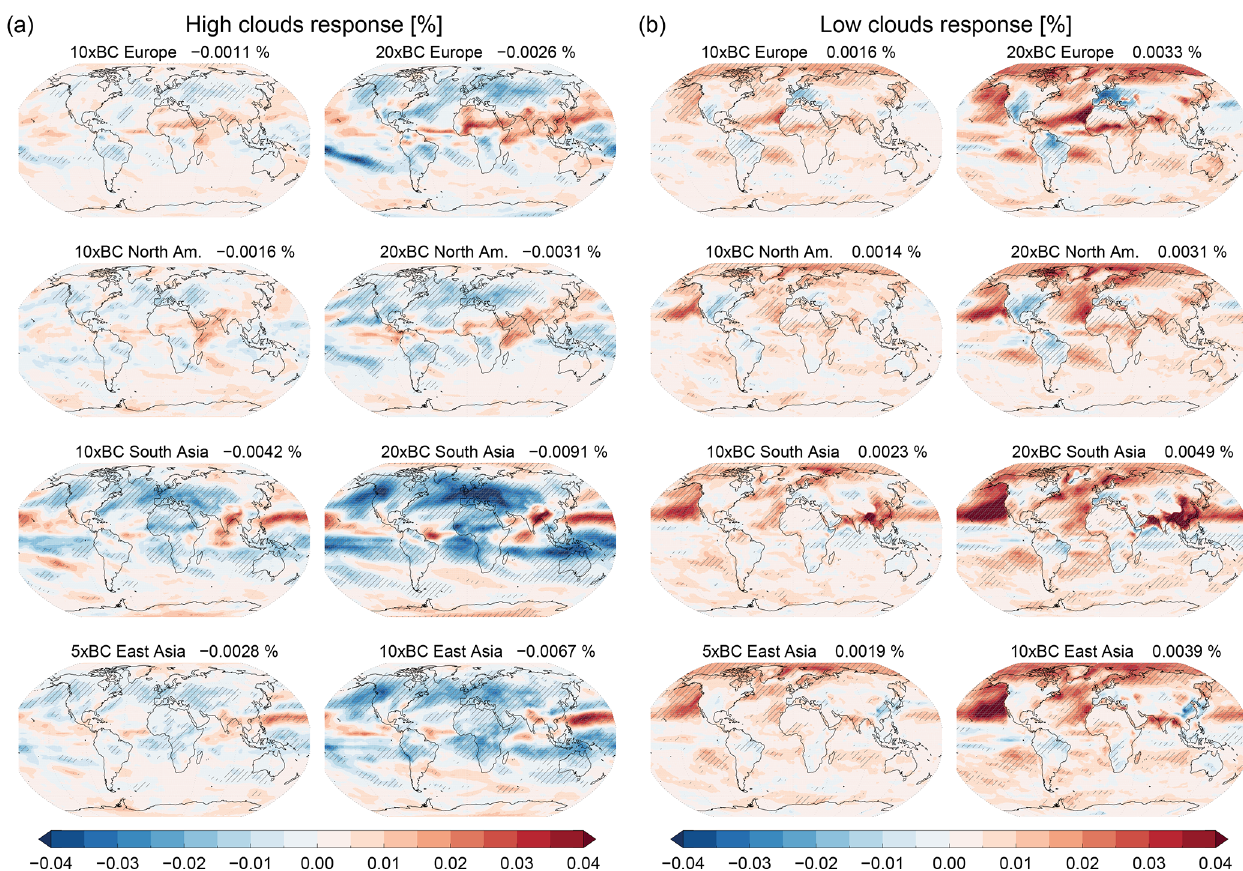
Figure 6. Response in high clouds (located above 400hPa) (a) and low clouds (surface up to 700hPa) (b) in %. The emission location (Europe, North America, South Asia, East Asia) is given at the top of each plot. In the right-hand side column the emission rate is doubled compared to the left-hand side